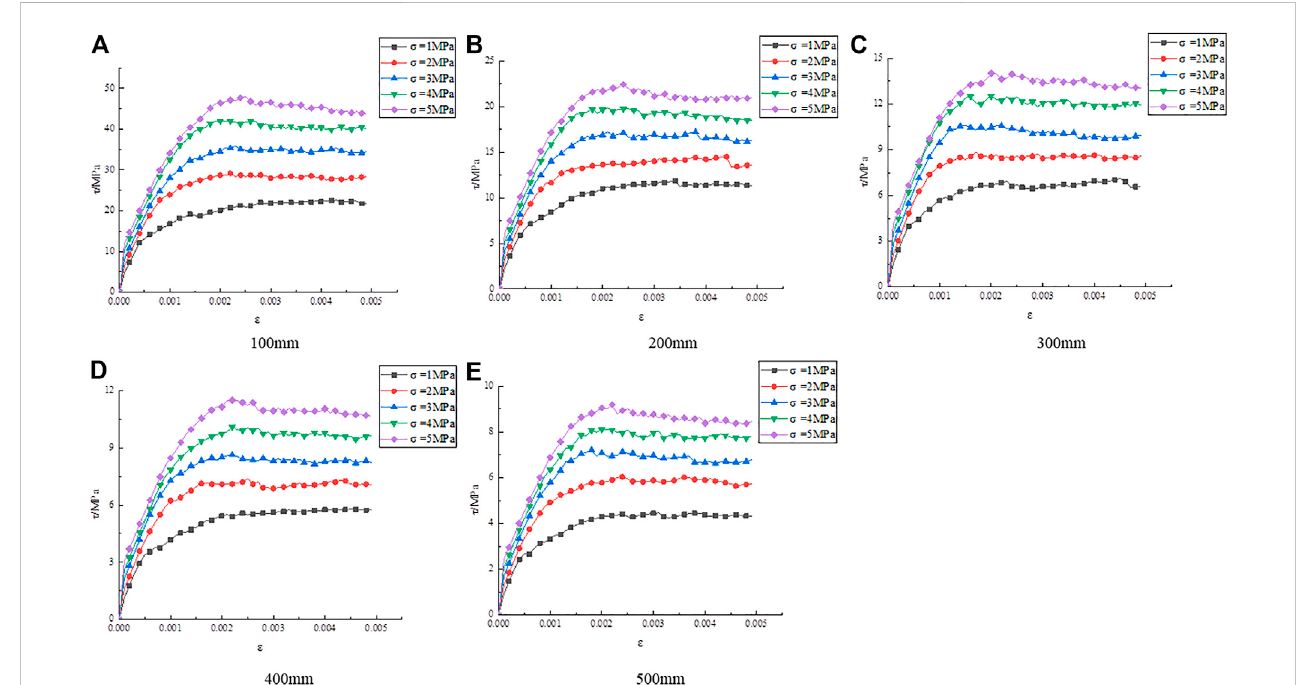
FIGURE 2 Stress – strain curves of different normal stresses.